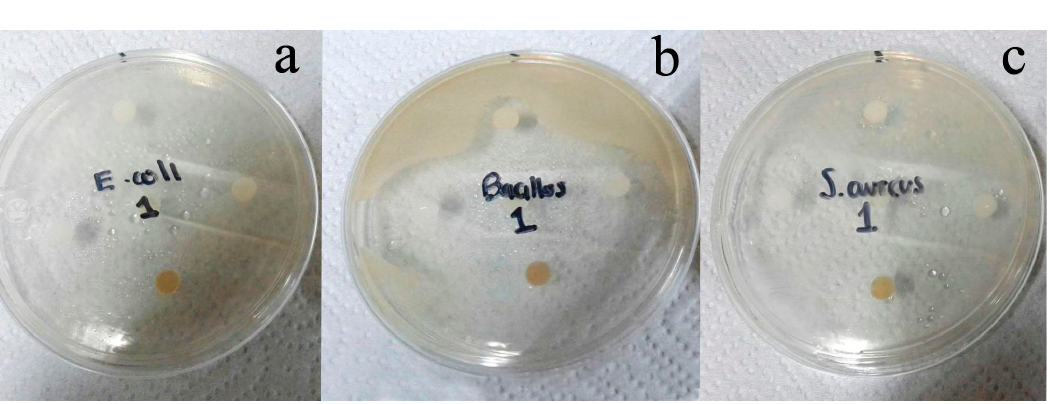
Figure 1. Antibacterial tests of the essential oil of leaves of P. dioica against ( a ) E. coli , ( b ) B. subtilis, and ( c ) S. aureus. and ( c ) S.